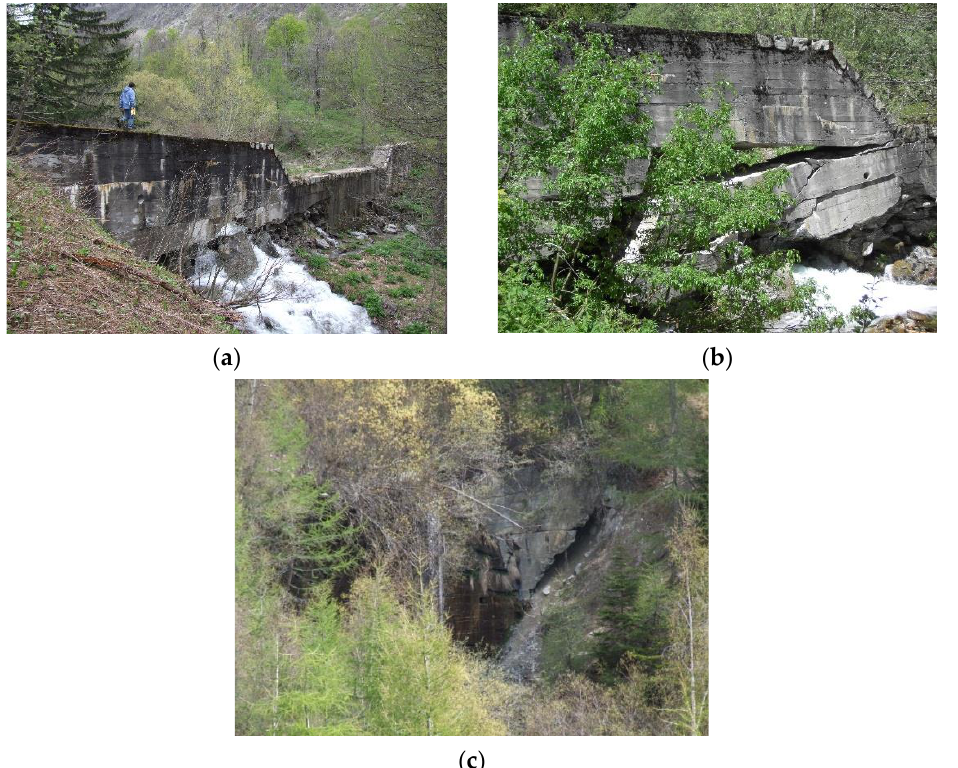
Figure 11. Overall and detailed view ( a , b , respectively) of a channel-bed-regulating concrete dam (photo taken on 20 May and 23 June 2008). Notice how the situation has worsened due to a debris- flow event that occurred on 28 – 30 May 2008. Following further debris-flow events, the conditions of the existing structures along the Ischiator stream were even more worrying for their stability due to the amount of detrital material that would suddenly reach the streambed in case of collapse of the dam ( c , in summer 2021).